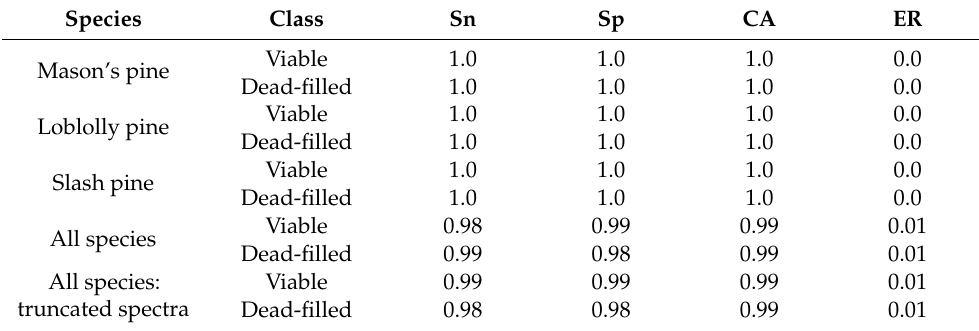
Table 3. Classification performance of models fitted on whole NIR spectral region (780–2500 nm) and truncated NIR spectra (1870–1950 nm) for classifying viable and dead-filled seeds of three pine species in the validation set ( n = 60 seeds per class and species). Where Sn, Sp, CA and ER denote class sensitivity, class specificity, classification accuracy and error rate, respectively.